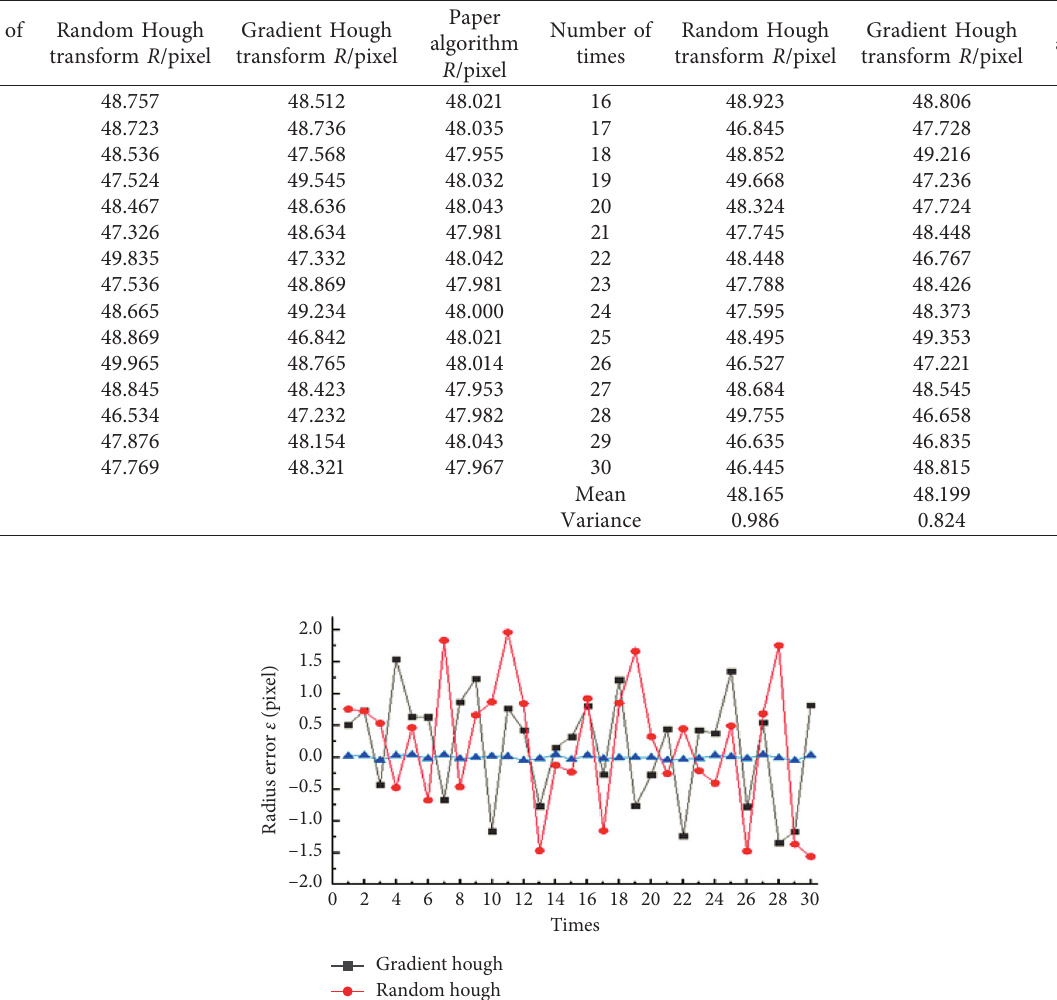
Table 7: Statistical table of 30 compensation hole radius size inspection.